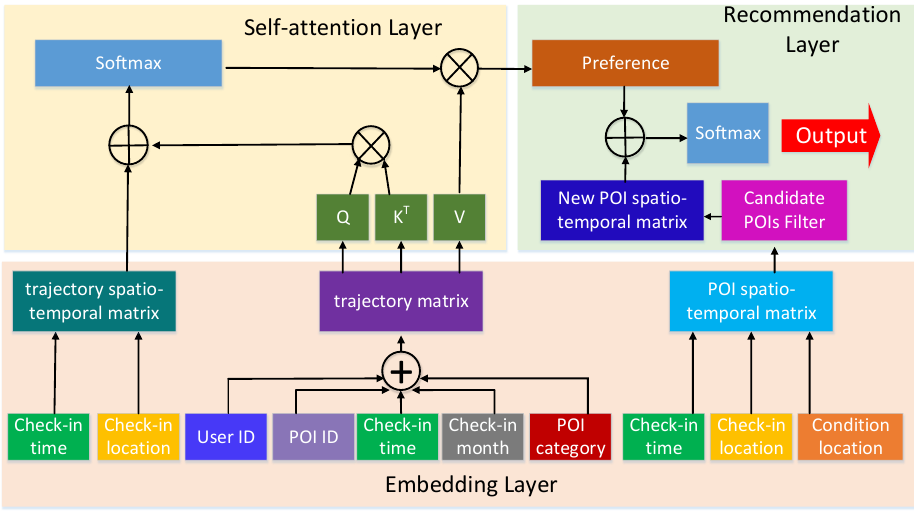
Figure 1. The framework of our